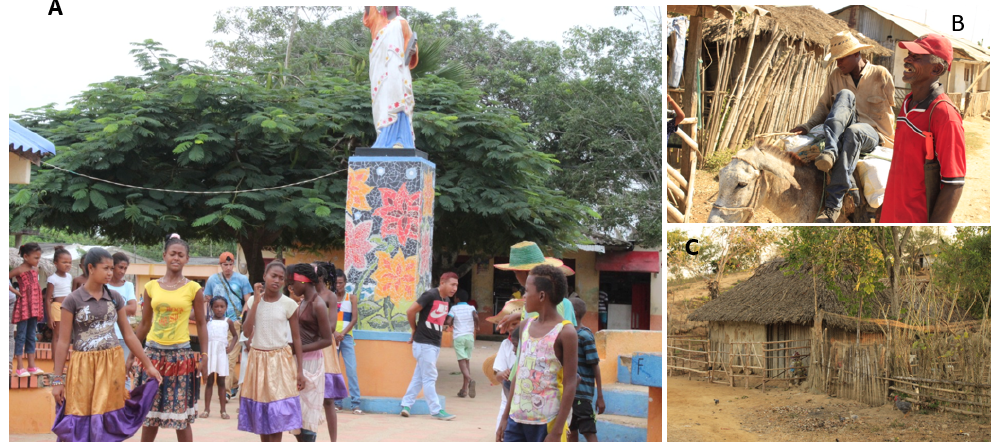
Figure 2. ( A ) Cultural expression of the natives of Libertad in the central park of the town, where they have their own version of the statue of Liberty; ( B ) natives of the town of Libertad in daily jobs; ( C ) ancestral dwellings of the village of Libertad. All photographs were supplied for the manuscript by the Press Office of the mayor’s office of the municipality of San Onofre.